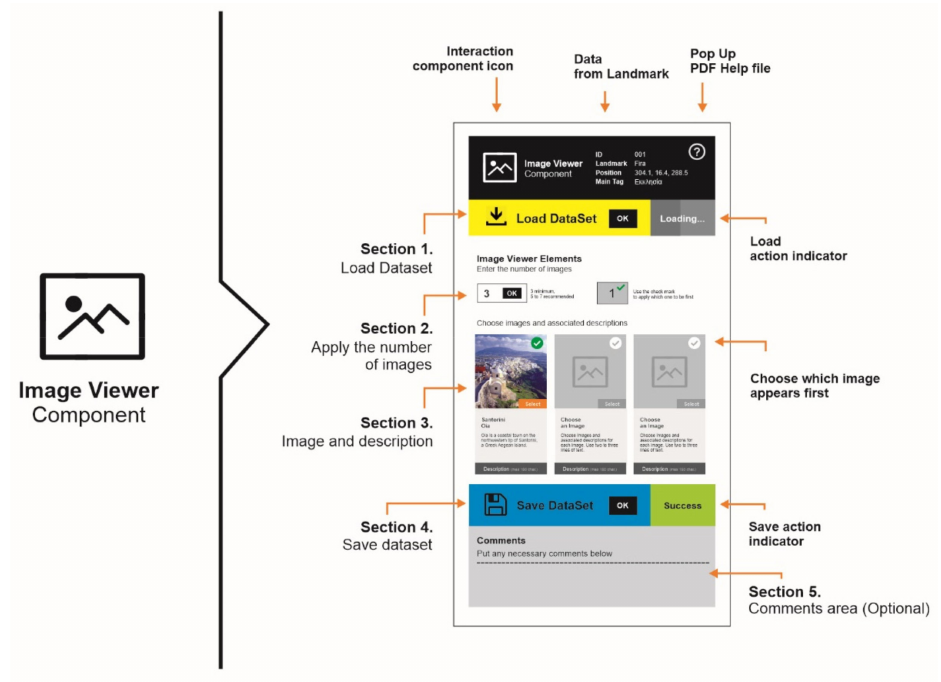
Figure 2. Image Viewer Interaction Component User Interface—showing the distinct sections of the